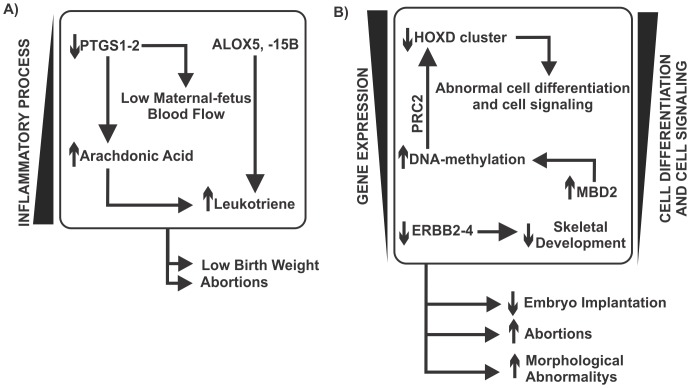
A model of the interactions from a systemic view showing how TCs affect development.In (A), we show that increasing TC levels generate a pro-inflammatory cascade by increasing the levels of PTGS1 and PTGS2. PTGSs are associated with inflammatory responses and are essential for normal pregnancy. Disturbances in PTGS expression could cause impairments in fetal development. TCs are connected to ALOX5 and ALOX15B, which are proteins involved in the synthesis of leukotriene, a molecule that plays pivotal roles in pro-inflammatory responses. The consequence of (A) is low birth weight in newborn infants, abortions and increased proliferation. Moreover, in (B), TCs are linked to BING2 and USP2, which are proteins related to increased activity of MDM2. This MDM2 mediated up-regulation can rapidly down-regulate p53 protein, leaving the cell more susceptible to DNA damage. TCs also down-regulate HPRT1, diminishing purine metabolism. This system exhibits a relationship with increased proliferation. The systems in (C) shows that TCs are associated with the generation of superoxides due to up-regulating NADH oxidase, which increases ROS levels and, consequently, oxidative stress. Increased oxidative stress is known to be related to birth defects. In addition, system (C) is associated with low birth weight and low neutrophil activity. Moreover, (D) shows the relationship between TCs and low hormone synthesis and signaling. Exposure to TCs could have a negative effect on androgen and estrogen solubility due to acting on the UGT cluster. TCs could also be associated with low levels of cholesterol synthesis due to increasing the levels of CYPs and diminishing the levels of FDFT1 and FDPS, which are two enzymes related to cholesterol synthesis. Low cholesterol availability would decrease general hormone synthesis. In addition, TCs affect the transport of cholesterol to the mitochondria by acting on the membrane protein StAR. Finally, in (E), the system shows the relationships between TCs and decreased global gene expression and cellular differentiation and signaling. The activities of the TCs would increase the levels of MBD2, a methylation enzyme. DNA methylation is related to gene silencing. We postulate that TCs could affect the PRC2 complex via its methylation and disturb gene expression, including that of HOX genes. TCs could also have a negative effect on gene expression by increasing YWHAH levels, which would decrease the levels of the master kinase PDPK1 and is linked to AKT activation and SMAD nuclear translocation. In addition, NOTCH signaling could be affected through the action of TCs on APP activation.